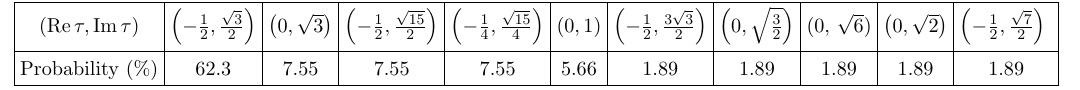
Table 2 . Probabilities of the stable vacua as functions of (Re (cid:28); Im (cid:28) ) in the descending order of the probability for N max = (cid:13)ux